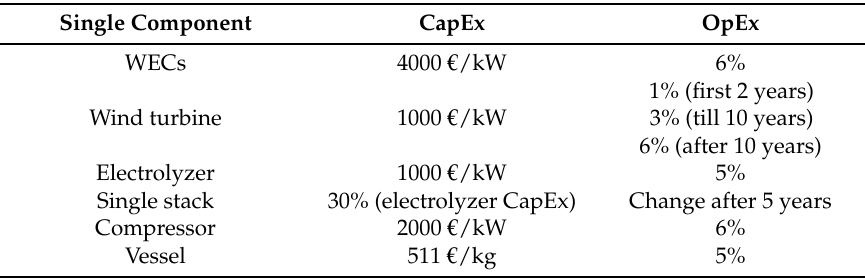
Table 7. Economic assumptions [6].